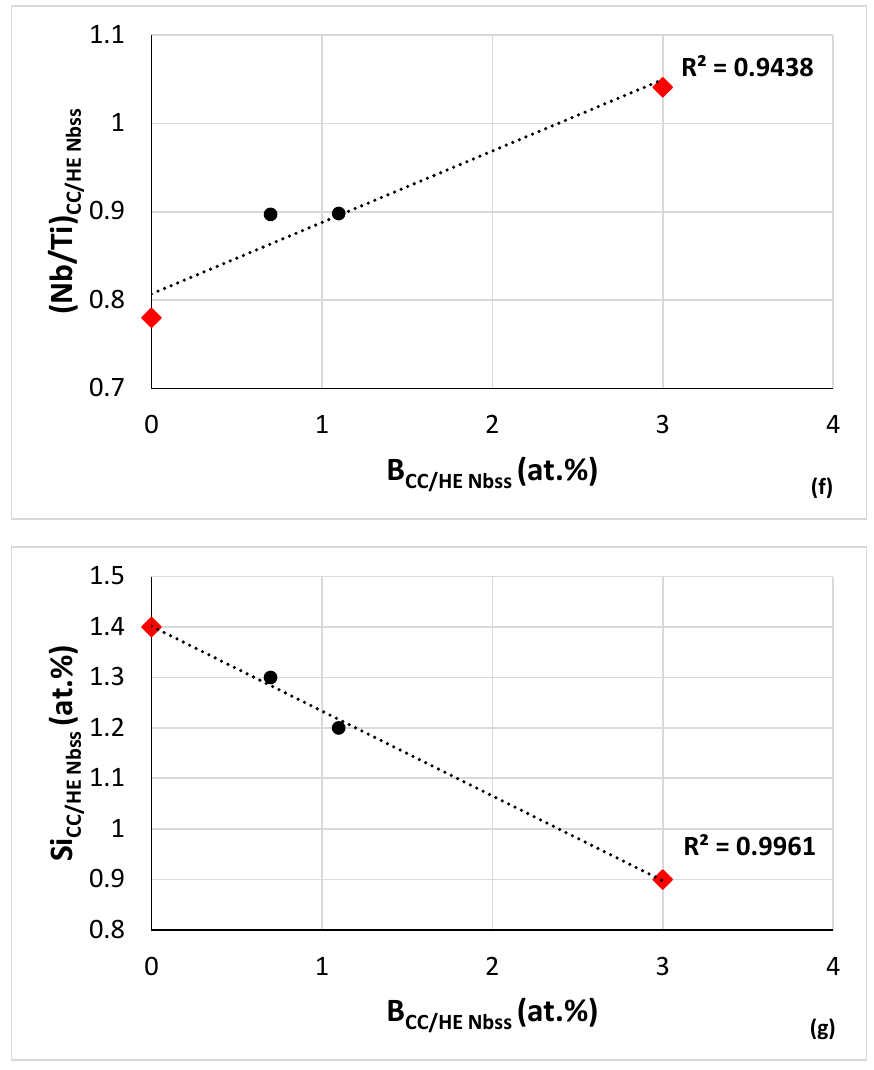
Figure 8. ( a – g ) data for the as cast B containing alloys TT4, TT5, TT7, TT8. Diamonds for RM(Nb)ICs/RCCAs. Concentration of B versus ( a ) Ti, ( b ) Cr, ( c ) Al, ( d ) Al+Cr and ( g ) Si in CC/HE Nb ss . ( e ) Al+Cr concentration versus Nb/Ti ratio and ( f ) Nb/Ti ratio versus B concentration in CC/HE Nb ss . R 2 values are for the linear fit of all data in each part. Parabolic fit of data in ( e ) gives R 2 = 0.9981 with maximum at Nb/Ti = 0.82 and (Al+Cr) = 23.22 at.%. HE Nb ss in TT4-AC. For nominal alloy compositions and references see Appendix A.